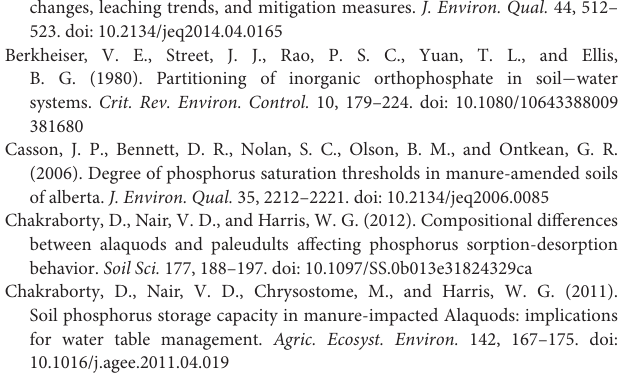
K L and K F , normally determined by more